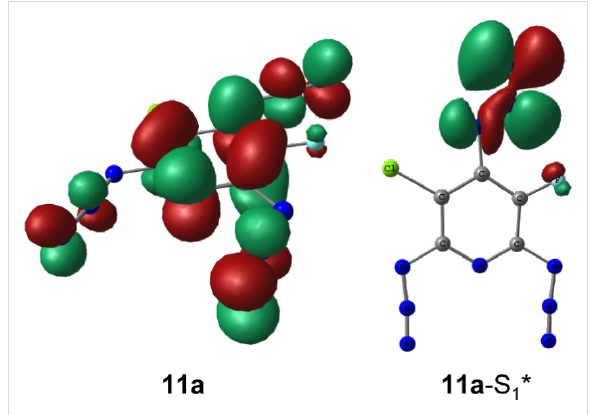
Figure 4: UB3LYP/6-311+G* orbital density in the LUMO of triazide 11 and CIS/6-311+G* orbital density in the highest singly occupied orbital of excited state 11a -S 1